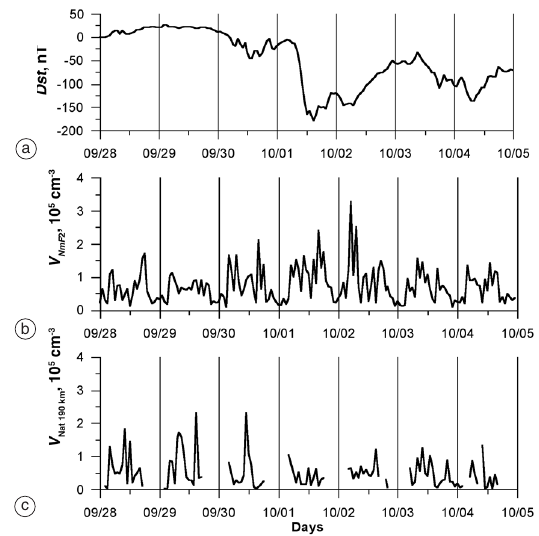
Fig. 12.4. Storm of September-October 2002: a) course of the hourly Dst index; b) course of the differendes between hourly NmF 2 and every 15 min NmF 2 obtained during each hour, (c) the same for electron density at 190